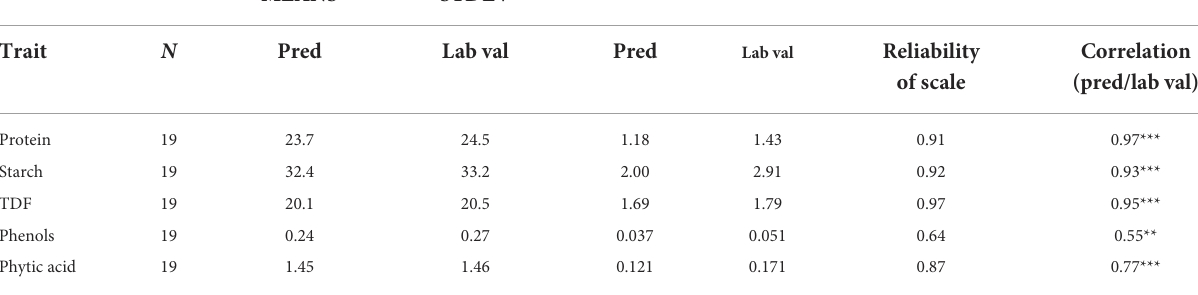
TABLE 6 Reliability analysis between predicted and laboratory validated values using strict parallel method. MEANS STDEV Lab val Pred Lab val Reliability